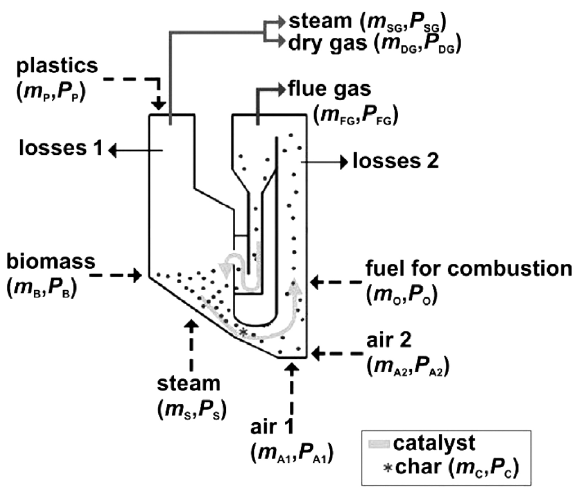
Fig. 1. Schematic representation of mass and heat flows. Losses of gasification reactor (losses 1) and losses of riser (losses 2) are pre- sented separately in this figure. Their sum represents the losses of plant. Original image is found in the literature.